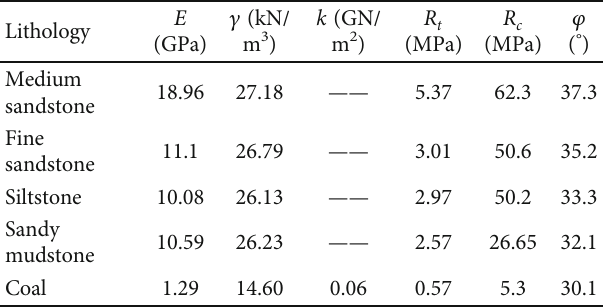
Table 2: Mechanical parameters of coal and